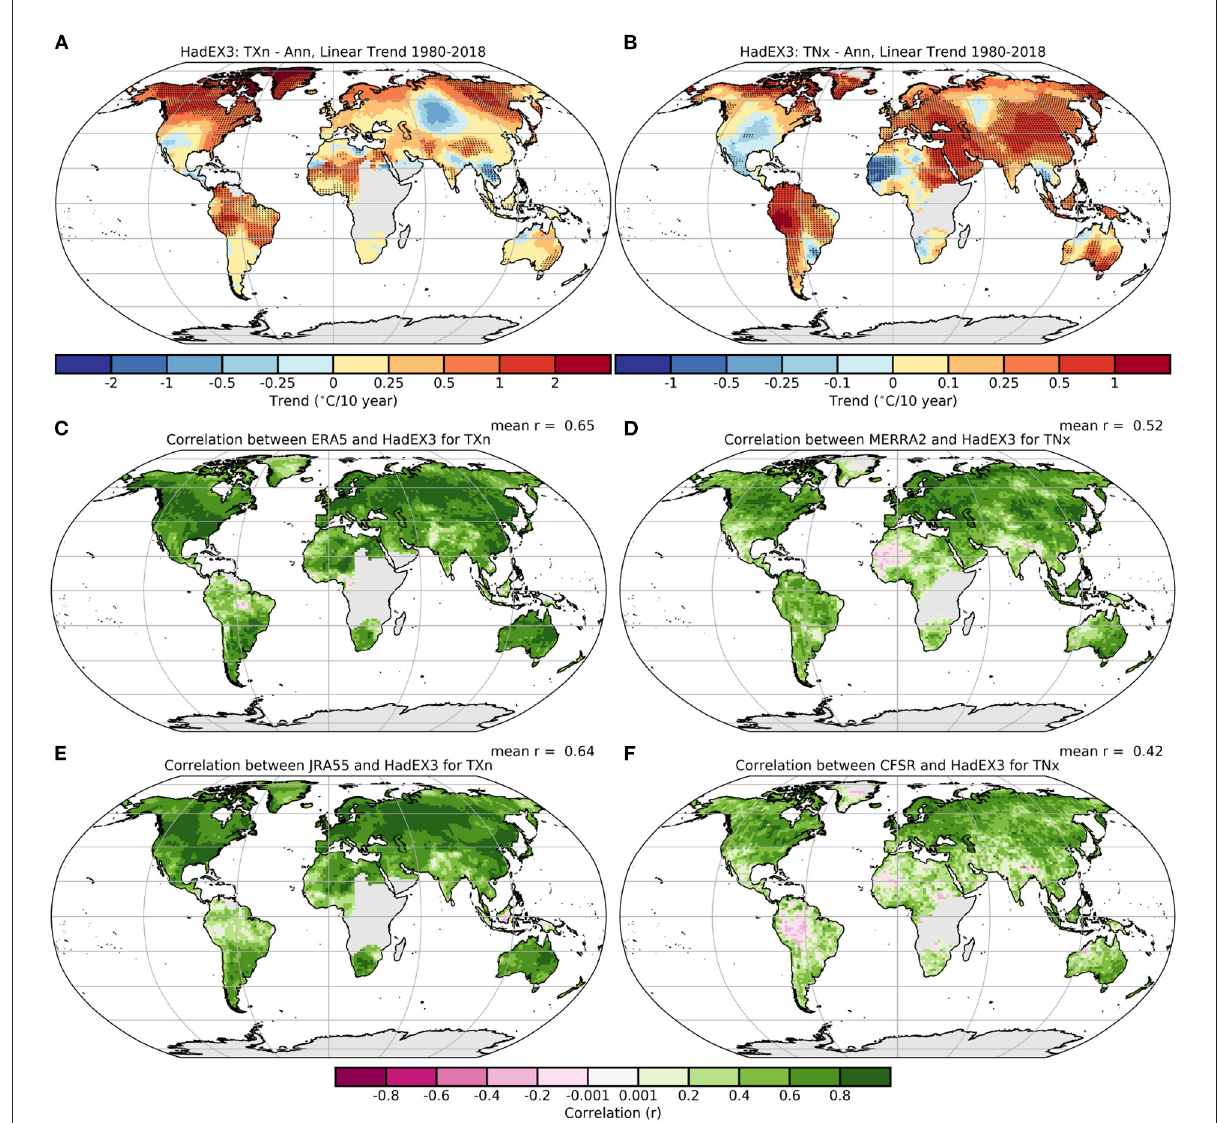
FIGURE4 (A,B) Linear trends in TXn and TNx in HadEX3 ( ◦ C/decade). Correlation maps for (C,E) TXn, and (D,F) TNx (anomalies relative to 1981–2010) with a selection of reanalyses (ERA5, MERRA-2, JRA-55, and